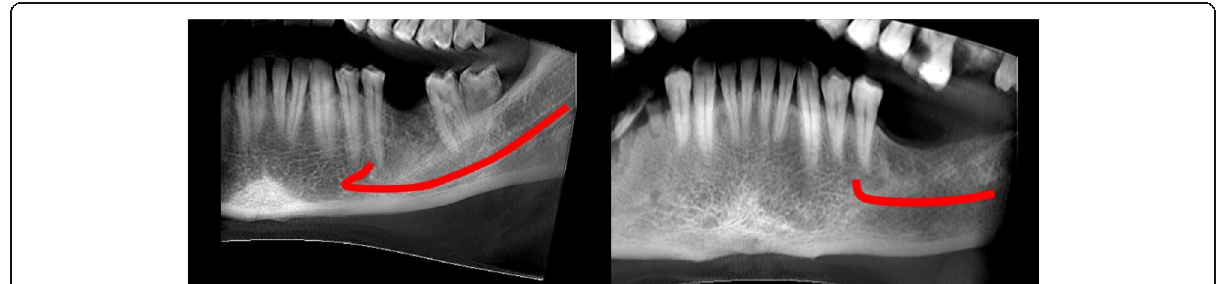
Fig. 2 Reconstructed panoramic view showing presence of anterior loop (left) and absence of anterior loop (right)